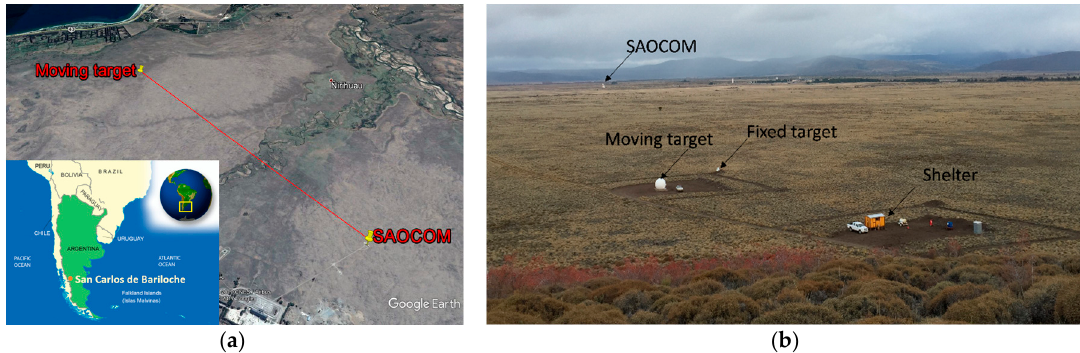
Figure 2. SAOCOM-1A outdoor test setup. ( a ) View on map; ( b ) aerial photo.